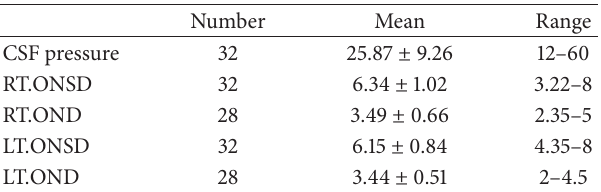
Table 1: Results (RT = right, LT = left, OND = optic nerve diameter, and ONSD = optic nerve sheath